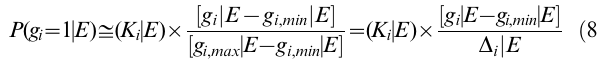
Figure 5. Transition states in the reprogramming. The cell states with larger than 1000 dynamical flux at each simulation step of reprogramming are shown for the 5 experimental recipes and the experimental recipes plus GATA6 knockdown. Figure S3 in Text S2. Next, to reduce inference complexity, we minimized the interface set. In particular, we ranked all candidates by a heuristic score = B/(1 2 A) . If this candidate is a must-cut node (loops must be cut at this node in order to keep the unrolled graph acyclic, such as auto-regulation node), A =1 , then its score becomes positive infinity (maximum). Otherwise A = 0 and score = B . B is the number of total loops of which this node is a member. If a node is not in a loop, then B=0 and score= 0 . The values of A and B associated with each interface candidate are listed in Table S2 in Text S2. We iteratively picked nodes with the biggest score value from the list and cut all outgoing edges which are part of any loop from this node. We repeated this step until all loops were broken. All selected nodes compose the outgoing interface and these nodes are {NANOG, SP1, Oct4-Sox2, CDX2, PIAS1, GATA6, FOXA2, FOXA1} (yellow-colored nodes in Figure 1B).